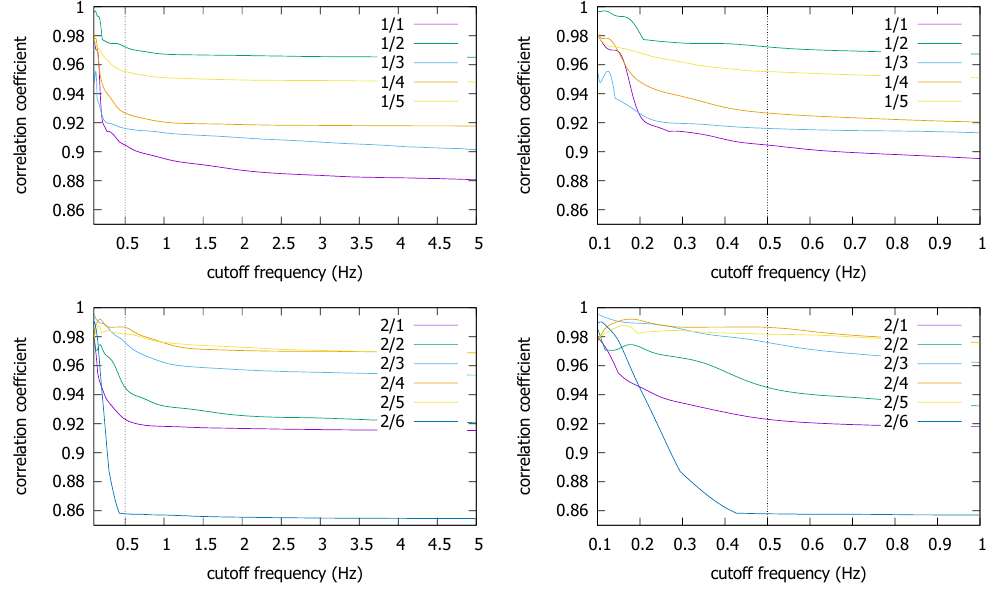
Figure 9. ρ max for coexistent traces in the Pisa dataset: Campaign 1 ( top ), Campaign 2 ( bottom